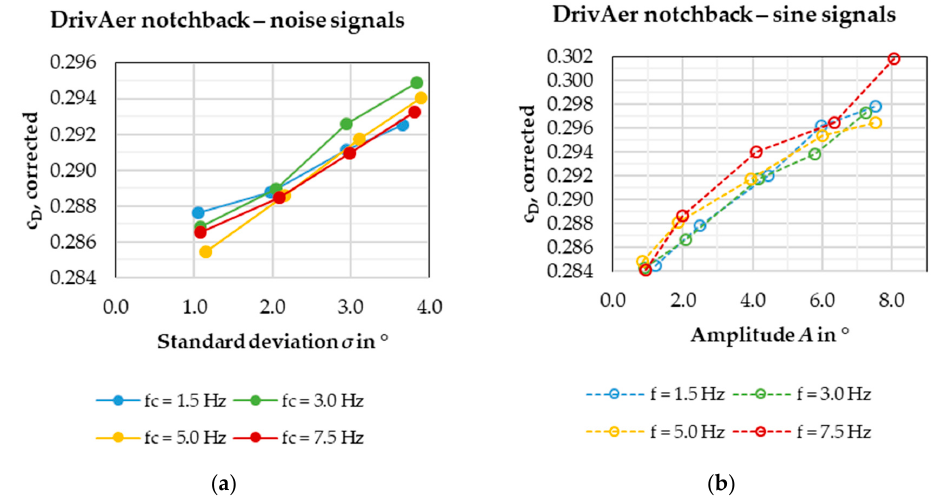
Figure 13. ( a ) Corrected 𝑐 (cid:3005) for the DrivAer notchback model, measured with the noise signals. ( b ) Corrected 𝑐 (cid:3005) measured with the sine signals.